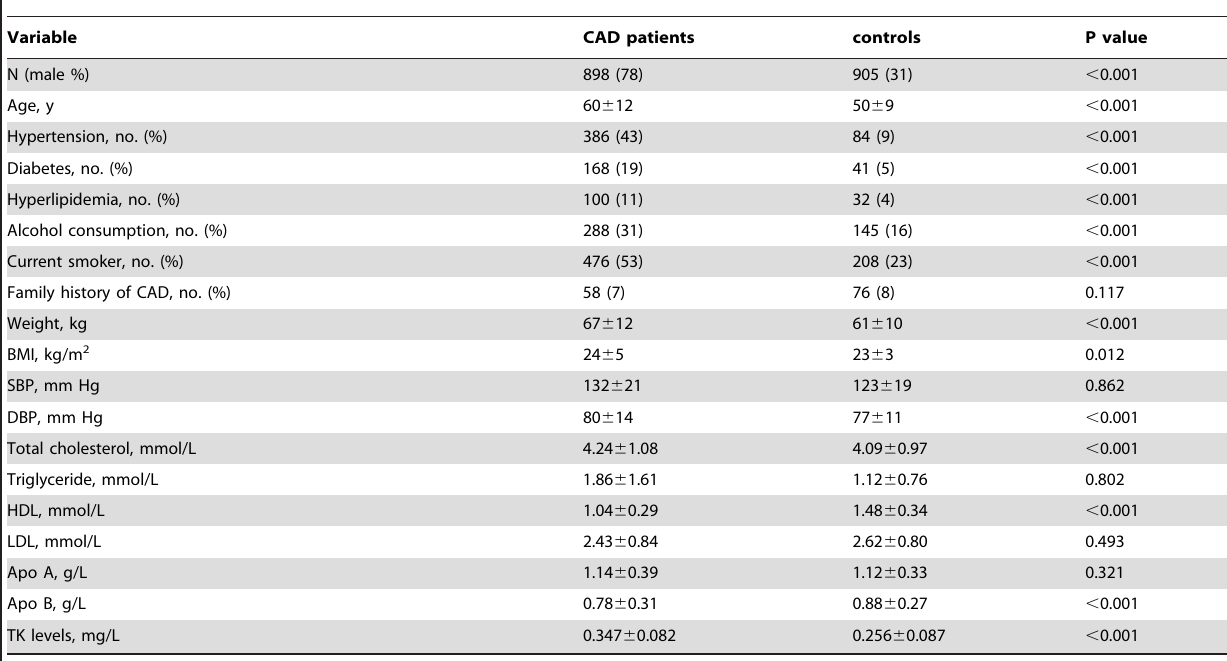
Table 1. General characteristics of CAD patients and controls.